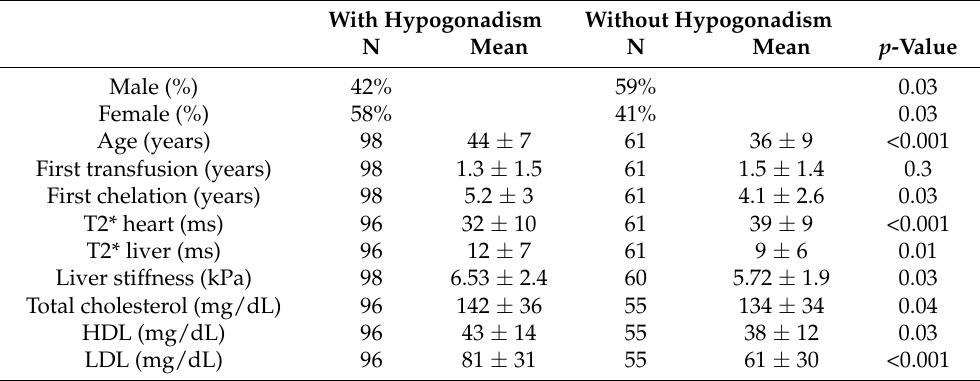
Figure 2. Kaplan–Meyer graphs of different cardiovascular outcomes according to gonadal state. Panel A: impact of hypogonadism on first diagnosis of early signs of heart failure; Panel B: impact of hypogonadism on the appearance of diastolic dysfunction; Panel C: impact of hypogonadism on first recognition of reduced ejection fraction; Panel D: impact of hypogonadism on supraventricular arrhythmias. Table 6. Clinical characteristics of patients with and without hypogonadism.